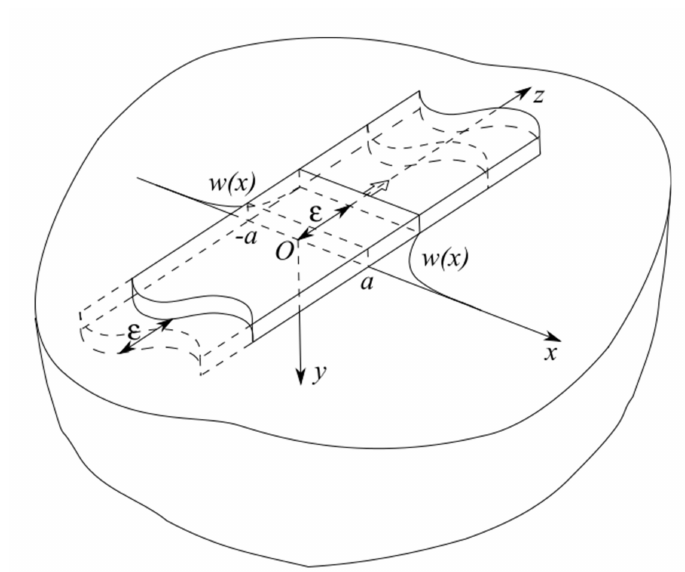
Figure 1. Scheme of pure shear of the functionally graded half-space surface by a strip